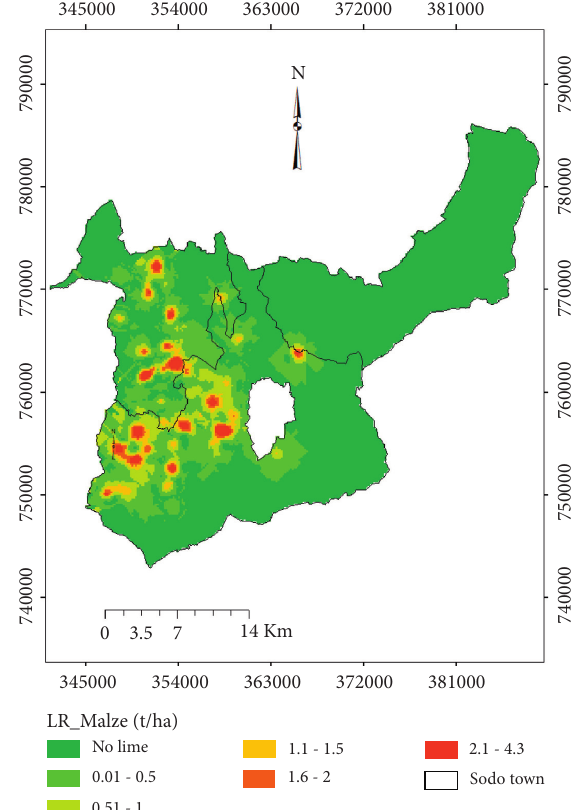
Figure 7: Extent and spatial distribution of lime requirement (t/ha) for legume (Haricot bean) production across the study site.